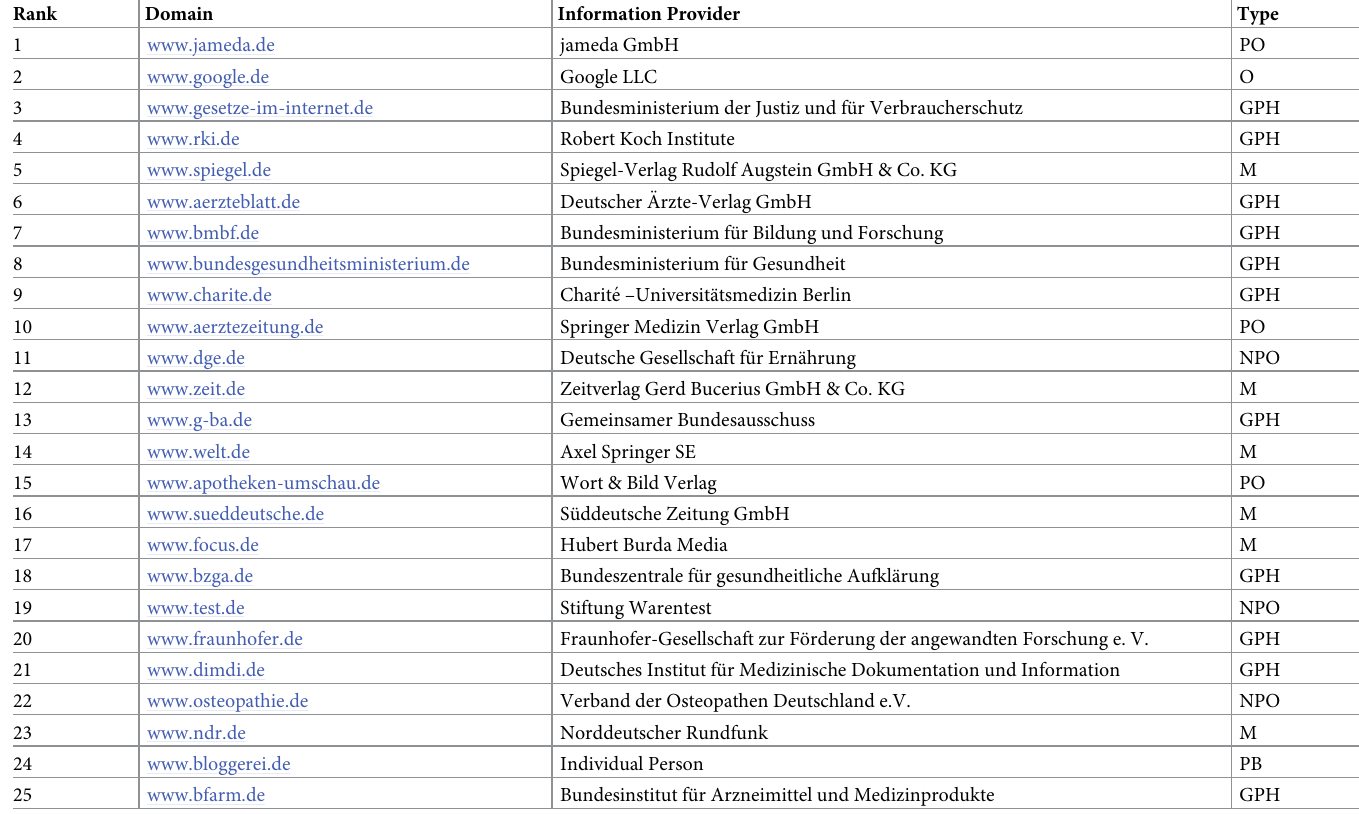
Table 1. Domains of 25 top-ranked web sites for ccTLD “.de” with their respective information provider according to